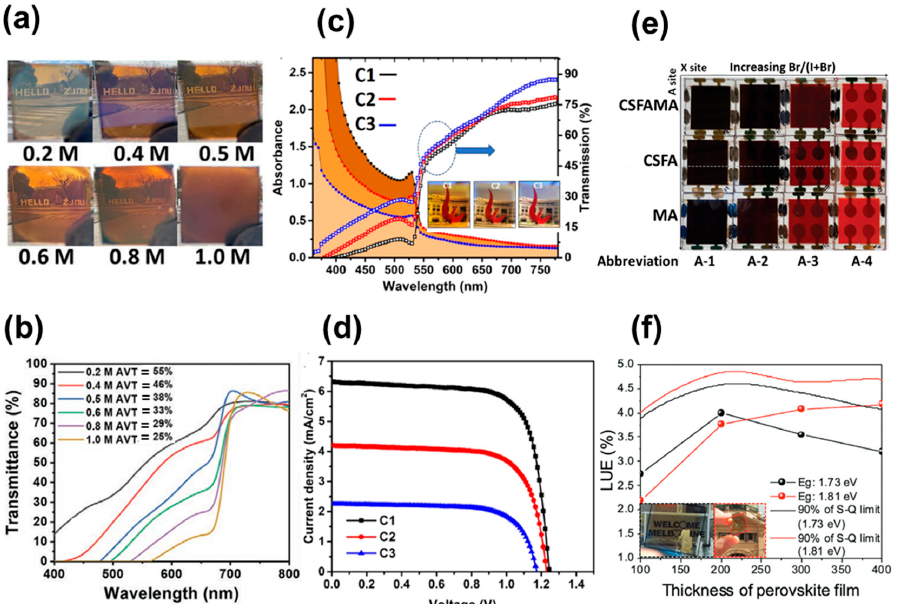
Figure 1. ( a ) Photographic images and ( b ) transmittance spectra of ST-PSCs for perovskite films with different concentrations. ( c ) UV-Visible absorption spectra and transmission spectra for device with FaPbBr 3 . ( d ) J-V curves with different concentrations. ( e ) Photograph of perovskite films’ perovskite compositions. ( f ) Dependence of LUE values on perovskite film thickness. Reprinted with permission from Refs. [25,27,28].